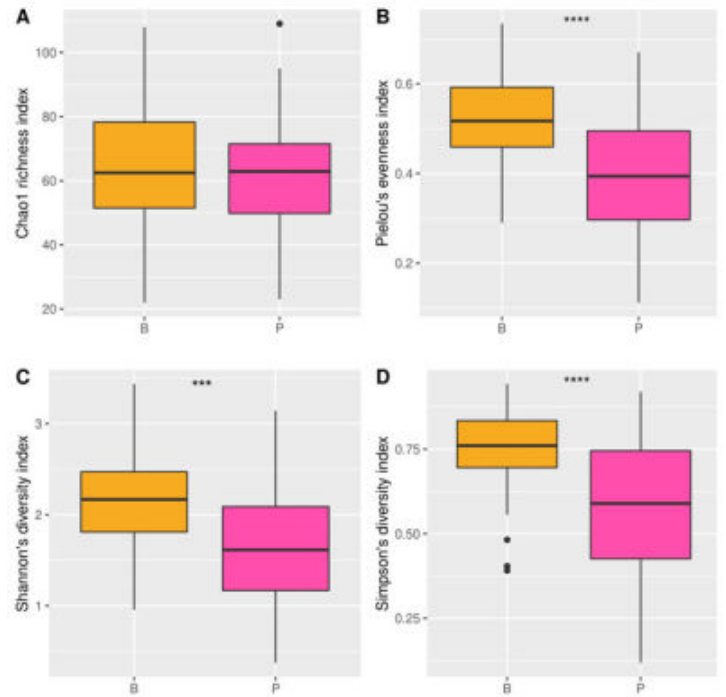
Figure 3. α -diversity analysis of gut microbiome composition in EnP and EnB with ( A ) Chao1, ( B ) Pielou’s evenness, ( C ) Shannon’s diversity, and ( D ) Simpson’s diversity indices. The symbols *** and **** represent p -value < 0.001 and p -value < 0.0001,